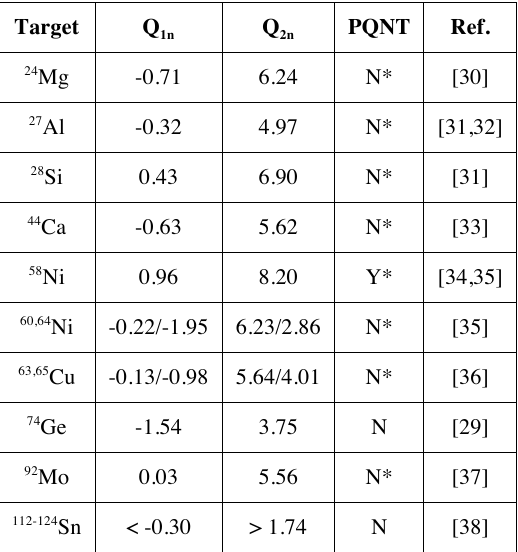
Table 1. Some typical systems of 18 O induced fusions.